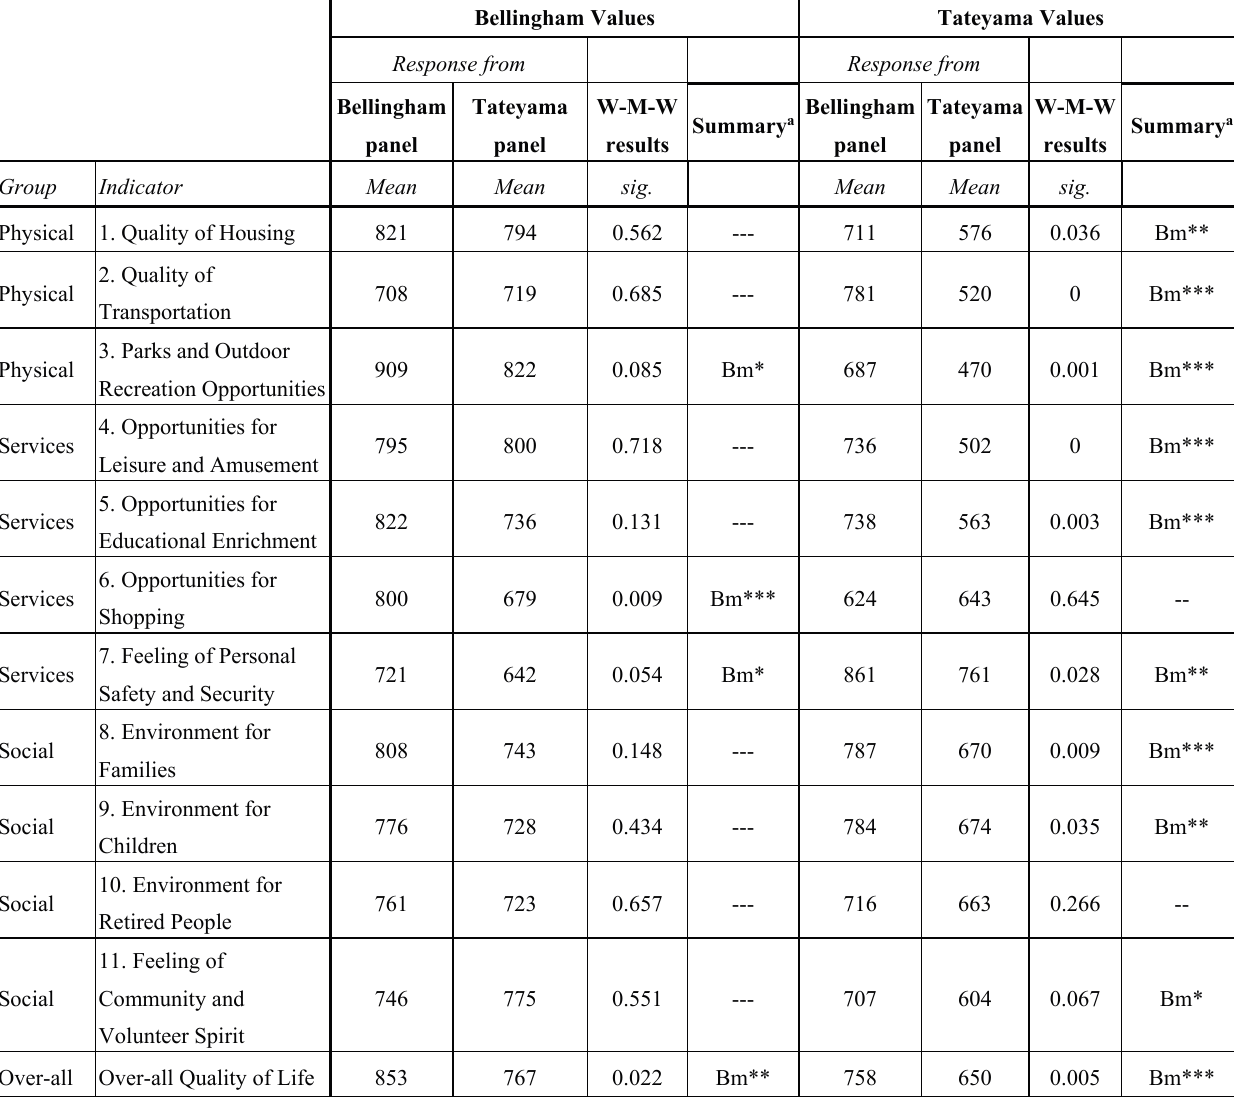
Table 2. Average of QOL indicators for each city by different panels and Wilcoxon-Mann- Whitney (W-M-W) Test